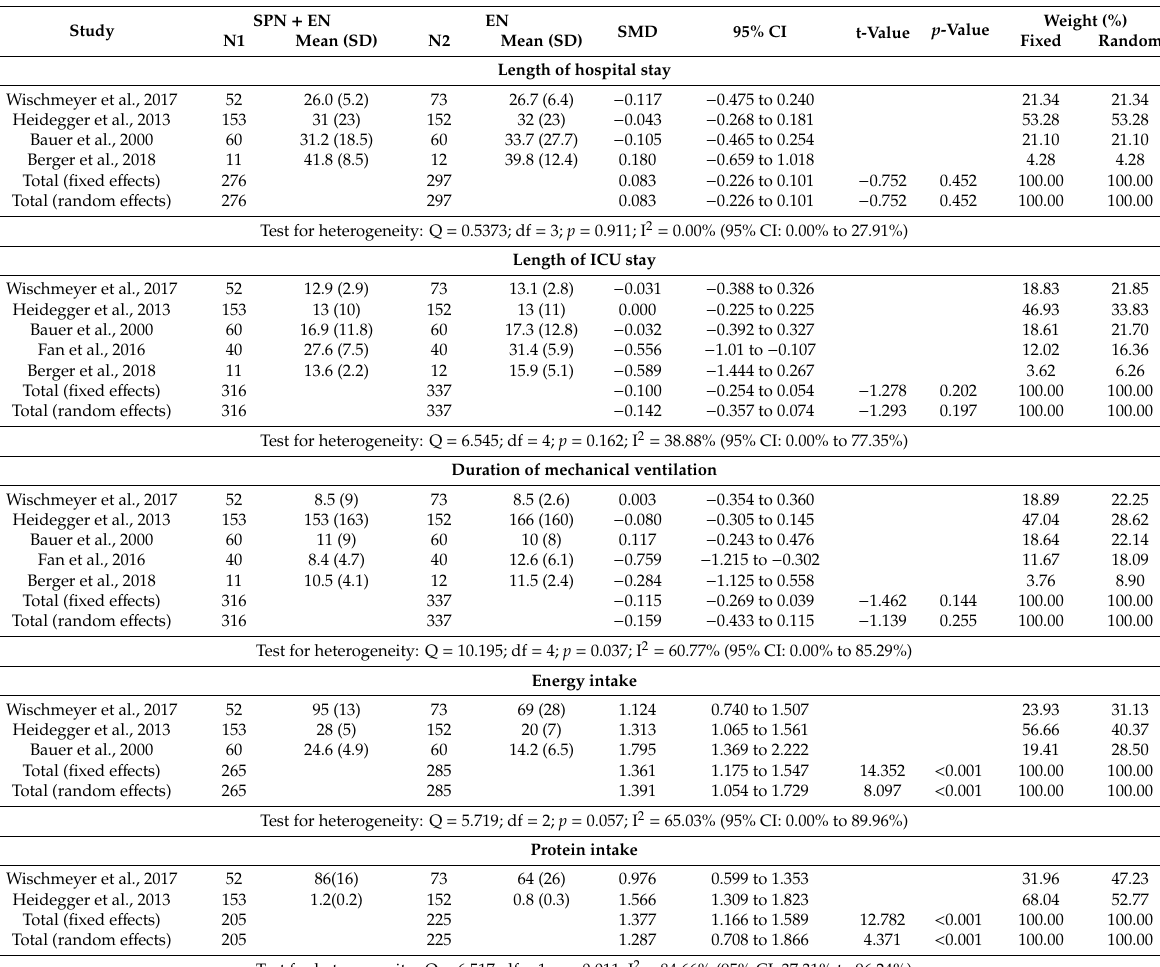
Table 3. Meta-Analysis for the outcome variables: length of hospital stay, length of ICU stay, duration of mechanical ventilation, energy intake, and protein